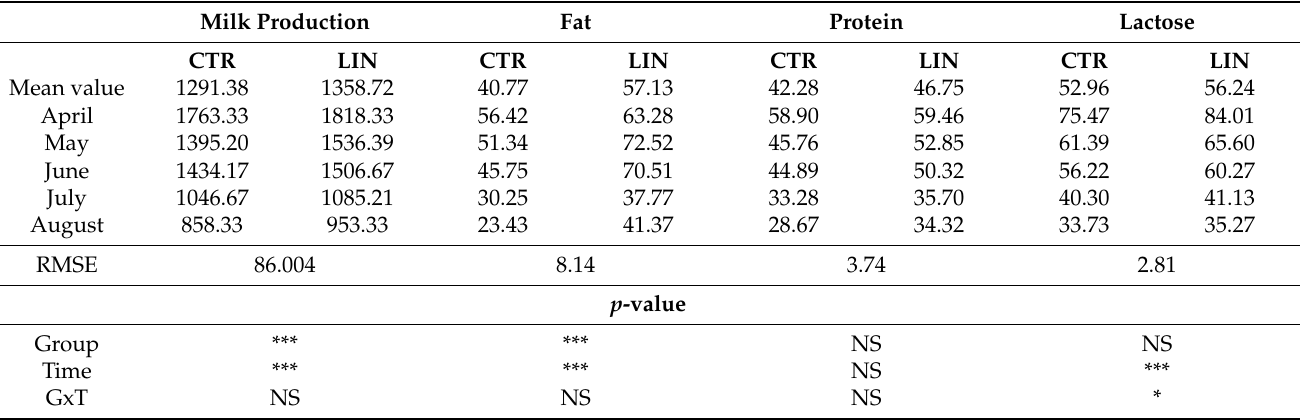
Table 2. Goats’ milk production and composition (mean value, g/head/day) of control (CTR) and linseed supplementation (LIN) groups.